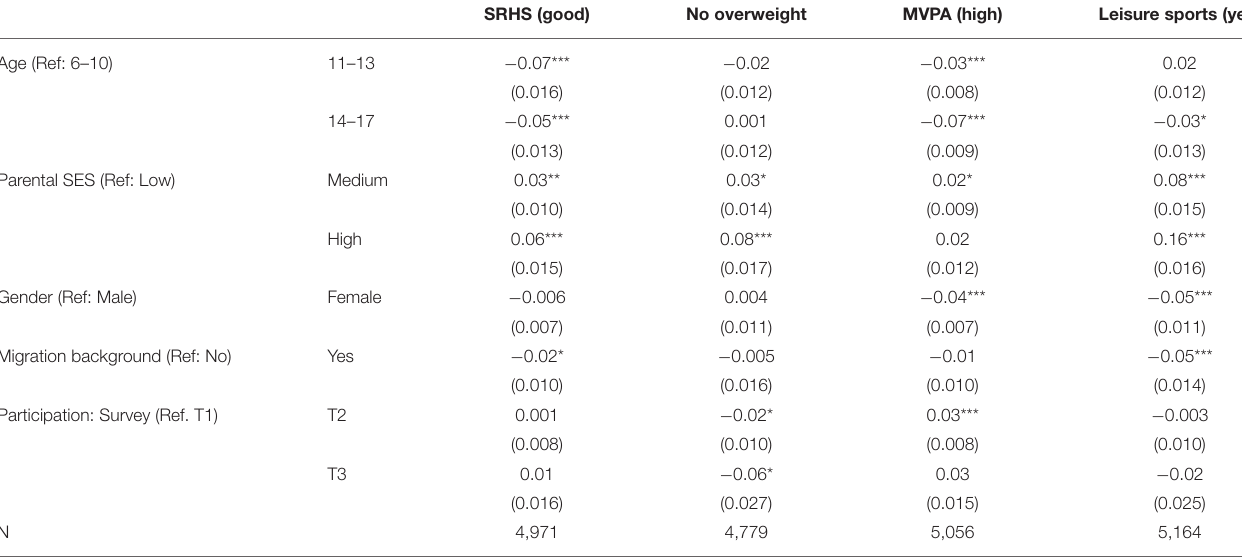
TABLE 3 | Logistic regression of (positive) health status and (positive) PA indicators on social status variables (Random effects; average marginal effects). SRHS (good) No overweight MVPA (high) Leisure sports (yes)